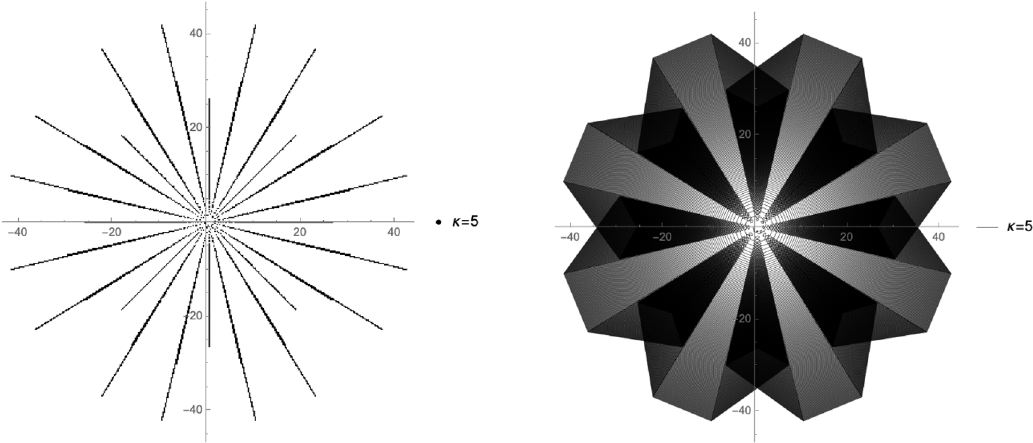
Figure 2 . Left: plot of Z with k = (cid:20) , (cid:16) = 0, m = 0 : 2 at (cid:12)xed (cid:20) = 5 and varying % = 1 ; : : : ; 10 4 . U(1) ; 1 % Right: same plot, with points obtained from consecutive values of % joined by a segment.